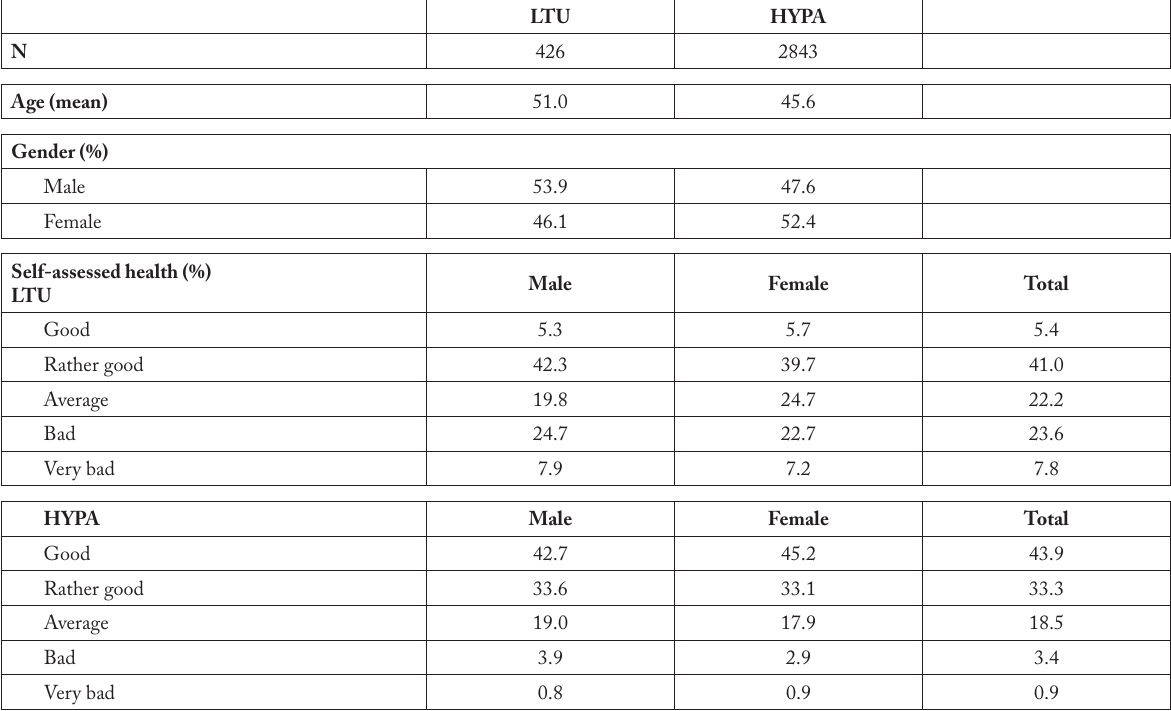
Table 1. Descriptive statistics of LTU and HYPA